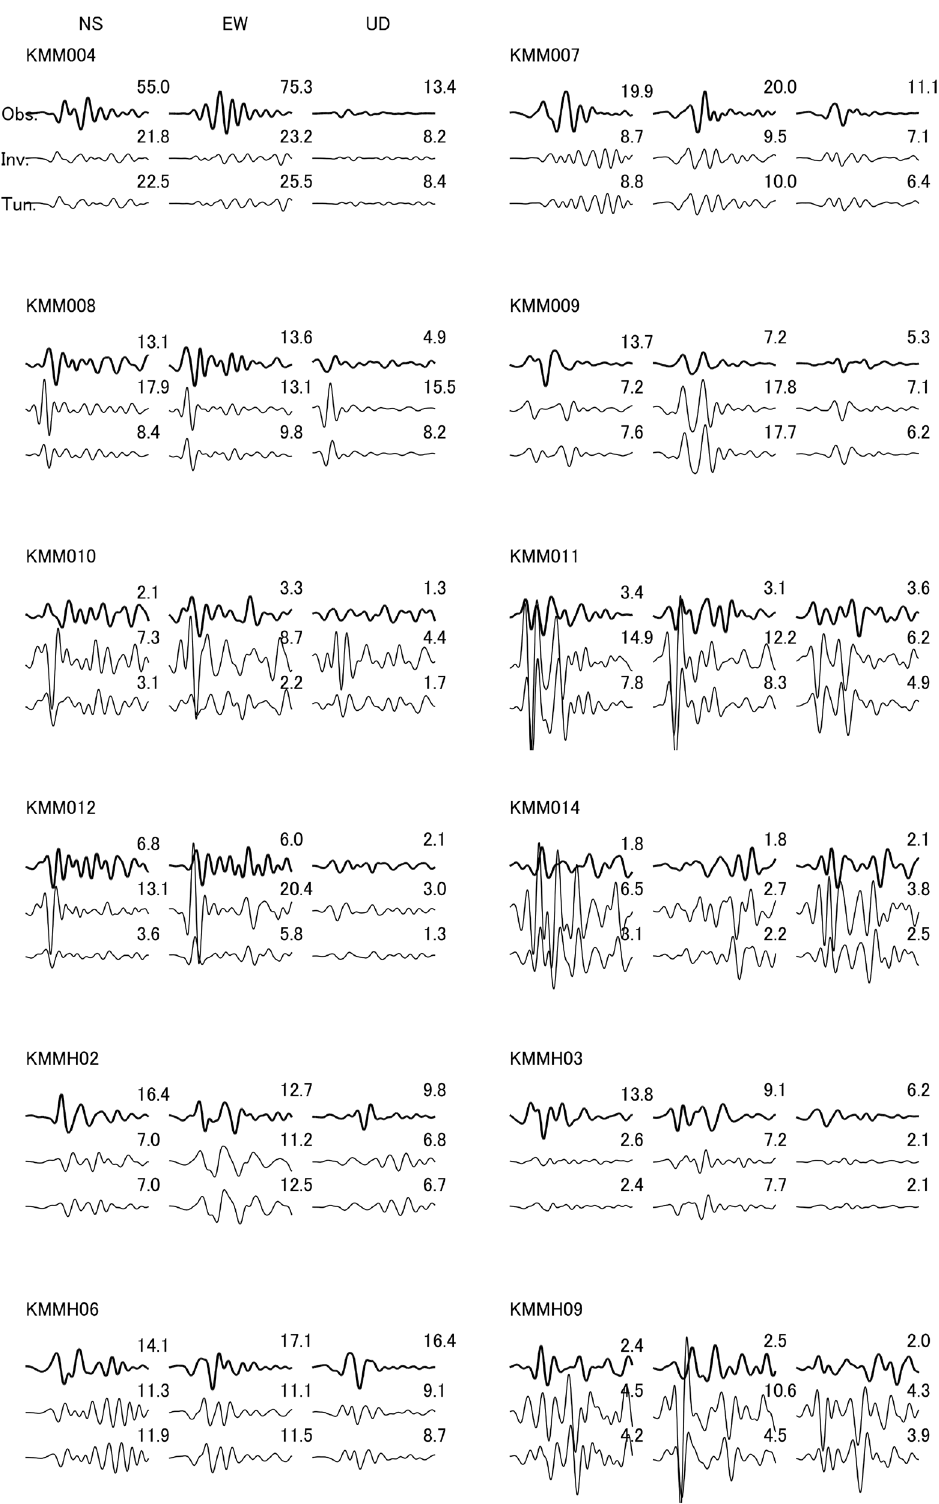
Fig. 10 Comparison of the observed velocities (thick) and the synthetic velocities (thin) for the 12 validation sites in Fig. 1, period range 2–10 s, waveform length is 30 s. The number in the right-hand side of each waveform is the peak amplitude in cm/s. For plotting, waveforms are scaled to the observed peak amplitude at each